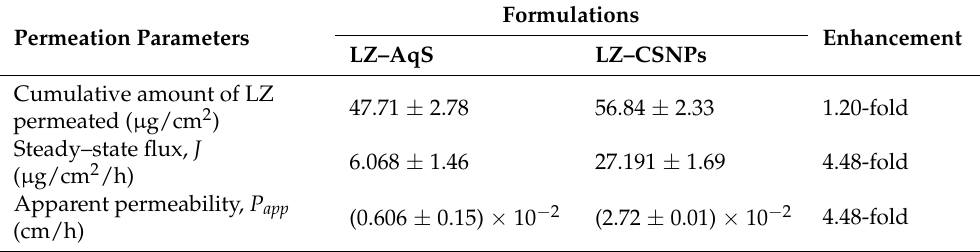
Figure 6. Transcorneal permeation of LZ from CSNPs and LZ–AqS. Results were represented as the mean of three measurements with standard deviation (Mean ± SD, n = 3). Table 7. Transcorneal permeation parameters from LZ–CSNPs and its counter formulation (LZ–AqS). The results are the mean of three measurements with standard deviations (Mean ± SD, n =